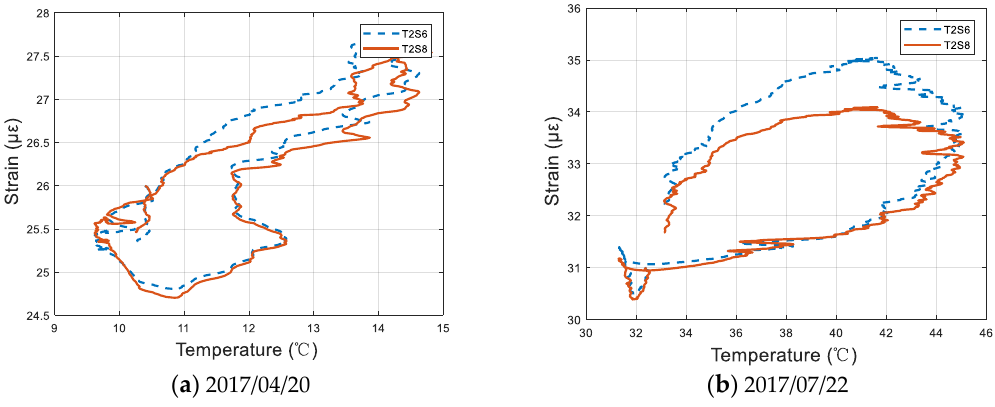
Figure 3. Plots of strain vs. temperature.